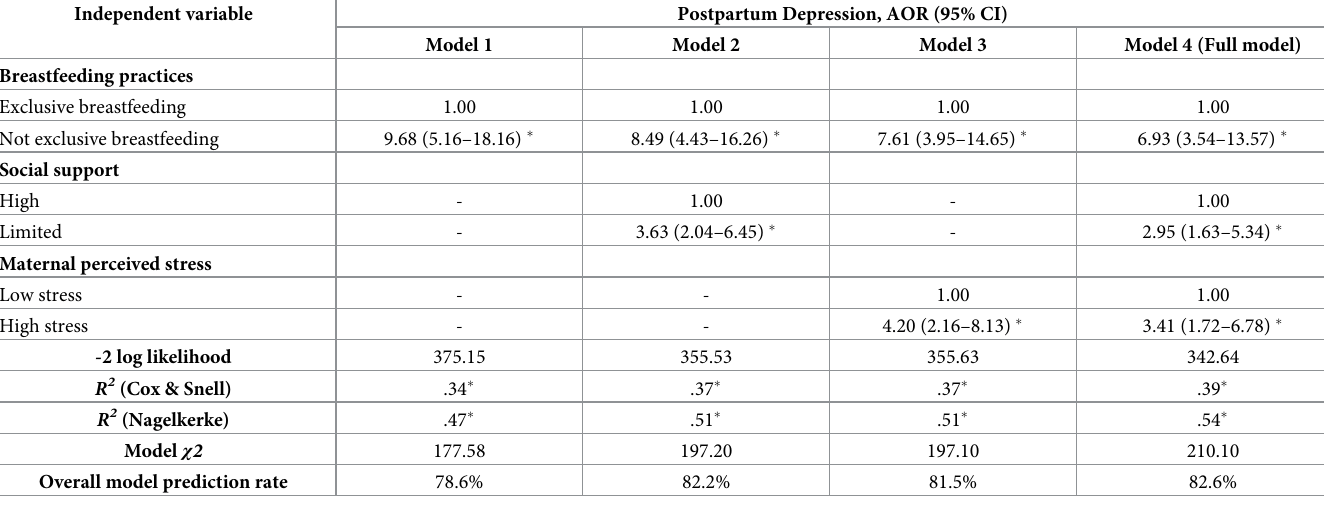
Table 2. Logistic regression Adjusted odds ratios (AOR) with Confidence Interval (CI) for the relationship between EBF and PPD among postpartum women in Bangladesh ( N =